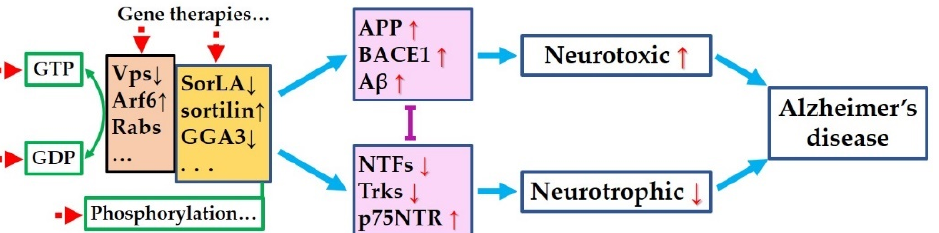
Figure 1. Hypothetical common pathogenesis and targets for Alzheimer’s disease. Amyloidogenic process and neurotrophic pathways are mutually inhibited. Original deficit in any of the two pathways may dysregulate the other one and mutually aggravate each other, or coordinately cause or deteriorate AD. Abnormal expression or activities of the regulators (brown and yellow boxes) result in the dysregulated expression or activities of the key proteins (pink boxes), leads to overloaded neurotoxicity and degraded neurotrophic effects, and finally, causes Alzheimer’s disease. Targeting these regulators (red dotted arrows)—including recover the expression levels or correcting the mutations via gene therapies or specific drugs, or modifying the activity to compensate for the dysfunction resulting from abnormal expression levels or mutation—might be effective strategies to treat AD.